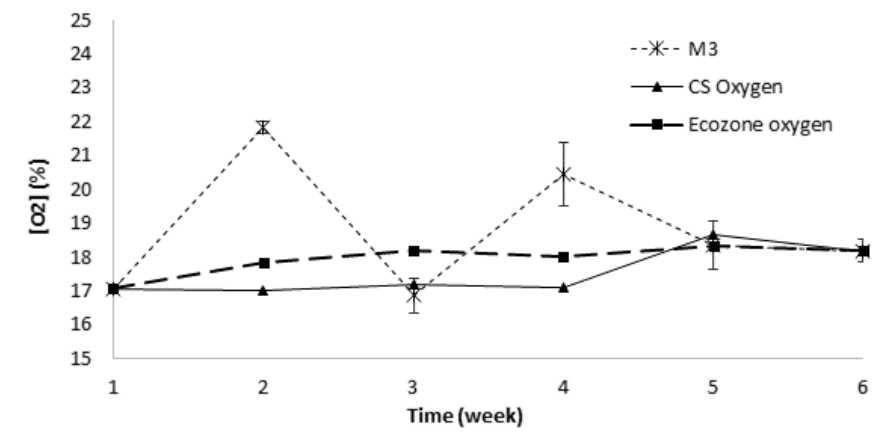
Figure 6. Static respirometry profiles.